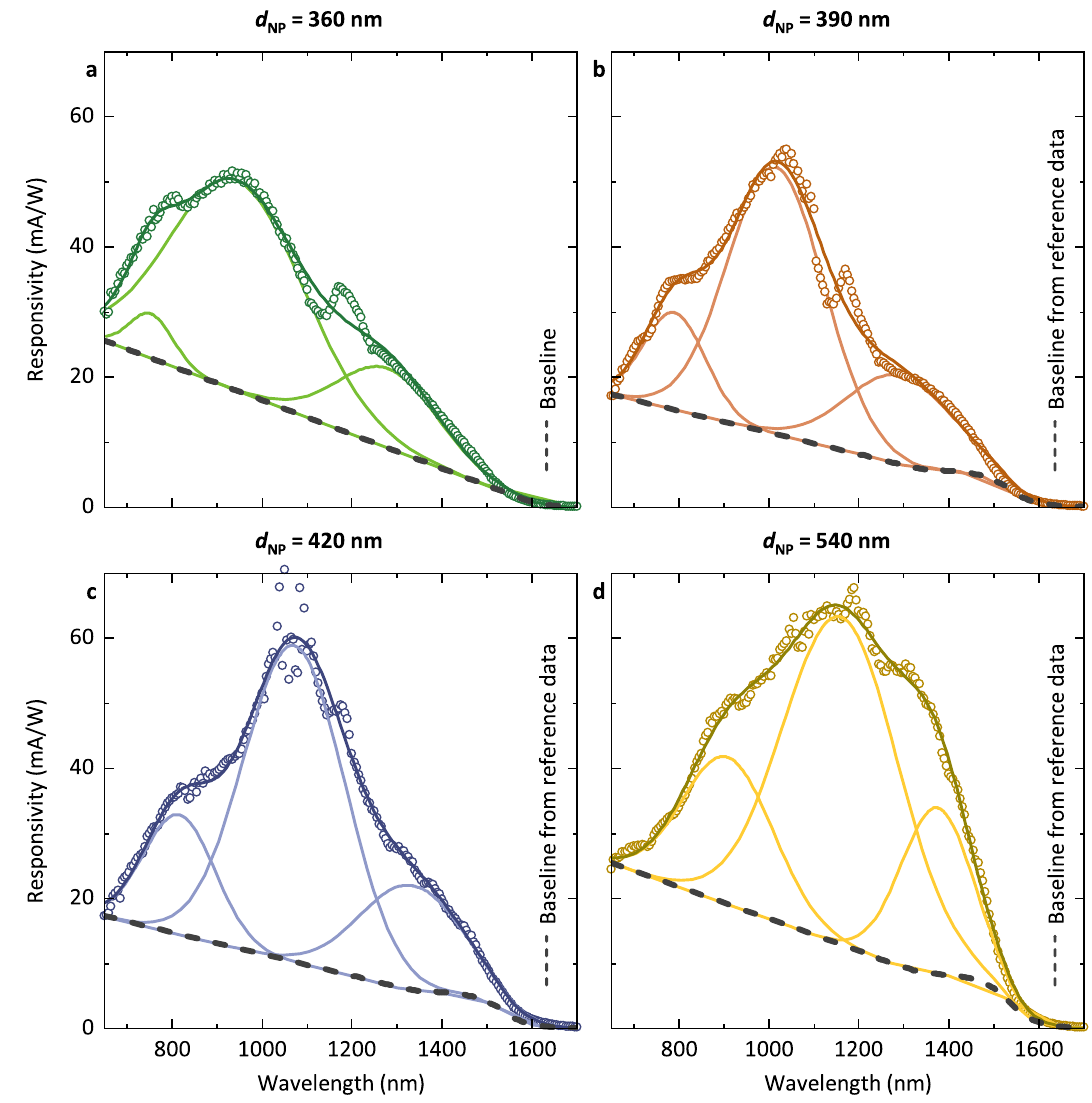
Figure 5. Measured spectral responsivity ( ○ ) of NP-PD devices with varying diameter d NP . For each measurement a peak analysis with three Gaussian functions (–) was carried out. The peak positions and corresponding errors are indicated in Fig. 3a. The baseline ( ‐ ‐ ‐ ) incorporates a reference responsivity spectrum obtained from a bulk photodetector with an identical semiconductor layer stack (see Fig. S7) and was adjusted for each measurement to take into account process variations. The peak at λ = 1180 nm is an artifact originating from the light source (wavelength of the pumping